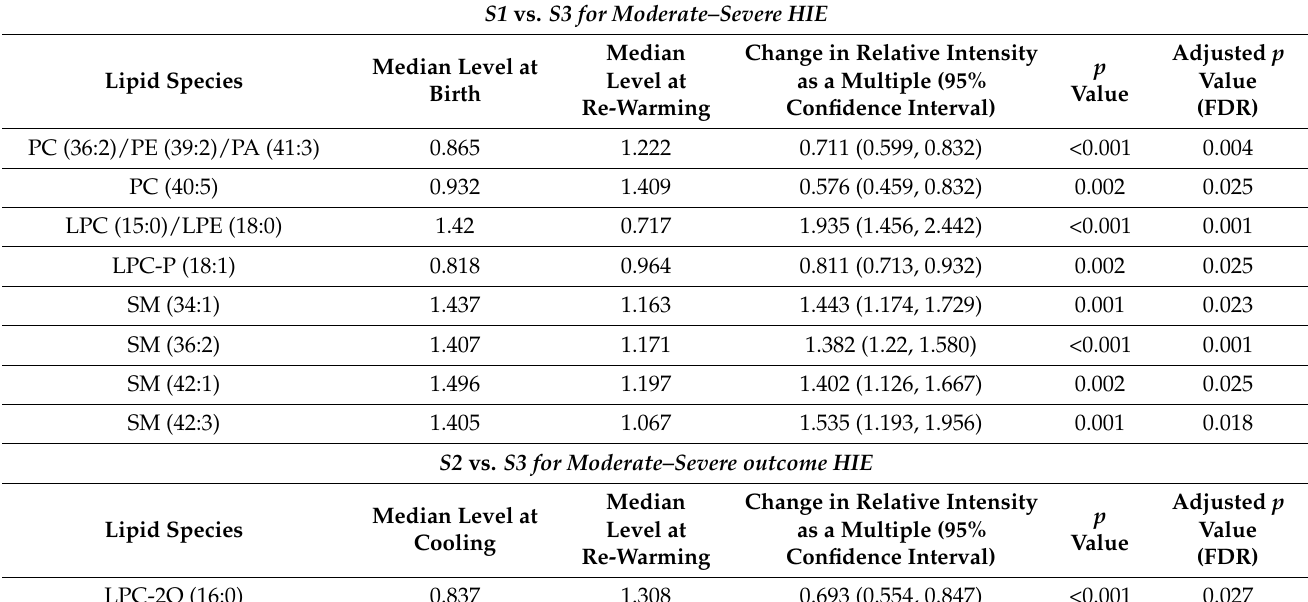
Table 4. Wilcoxon Signed Rank test statistics of the Moderate–severe HIE newborns when comparing different time points during therapeutic hypothermia (S1, S2 and